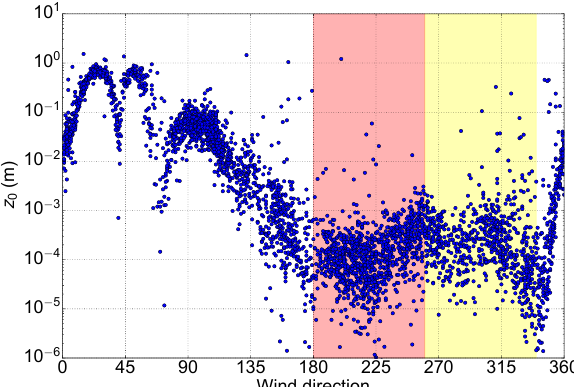
Figure B1. Surface roughness length as a function of wind direc- tion. The red band indicates the directions that are considered the open sea sector used in this paper, and the yellow band indicates a wind sector that potentially provides useful data that were excluded from the present